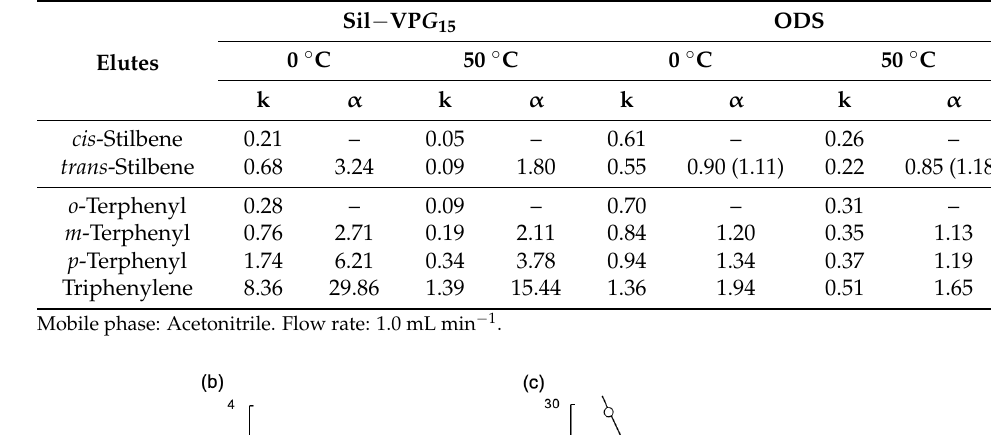
Figure 5. Chromatograms for ( a ) a mixture of cis -stilbene and trans -stilbene and ( b ) triphenylene and o -, m -, and p -terphenyls using Sil − VP G 15 and ODS as stationary phases. Mobile phase: Acetonitrile. Column temp.: 25 ◦ C. Flow rate: 1.0 mL min − 1 . Table 2. Retention factors (k) and separation factors ( α ) of stilbene and terphenyl isomers using Sil − VP G 15 and ODS.